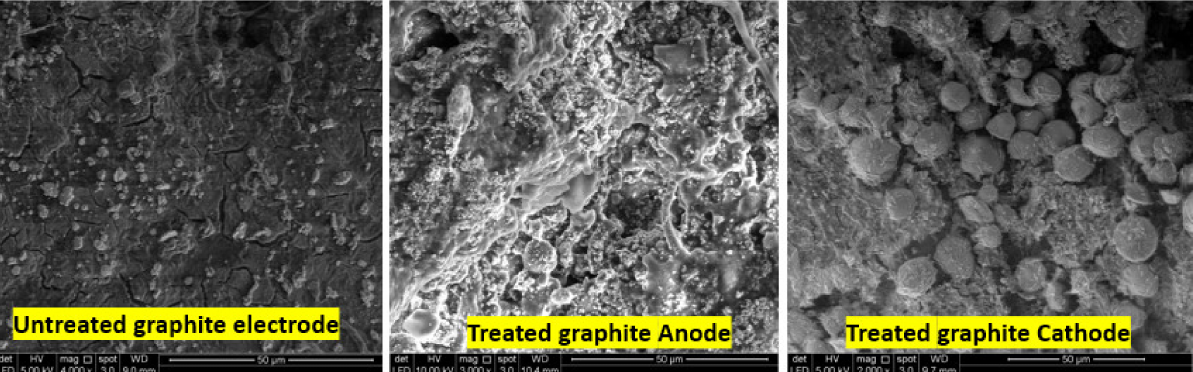
Figure 6. SEM analysis of treated anode and treated cathode after completion of BMFC operation.